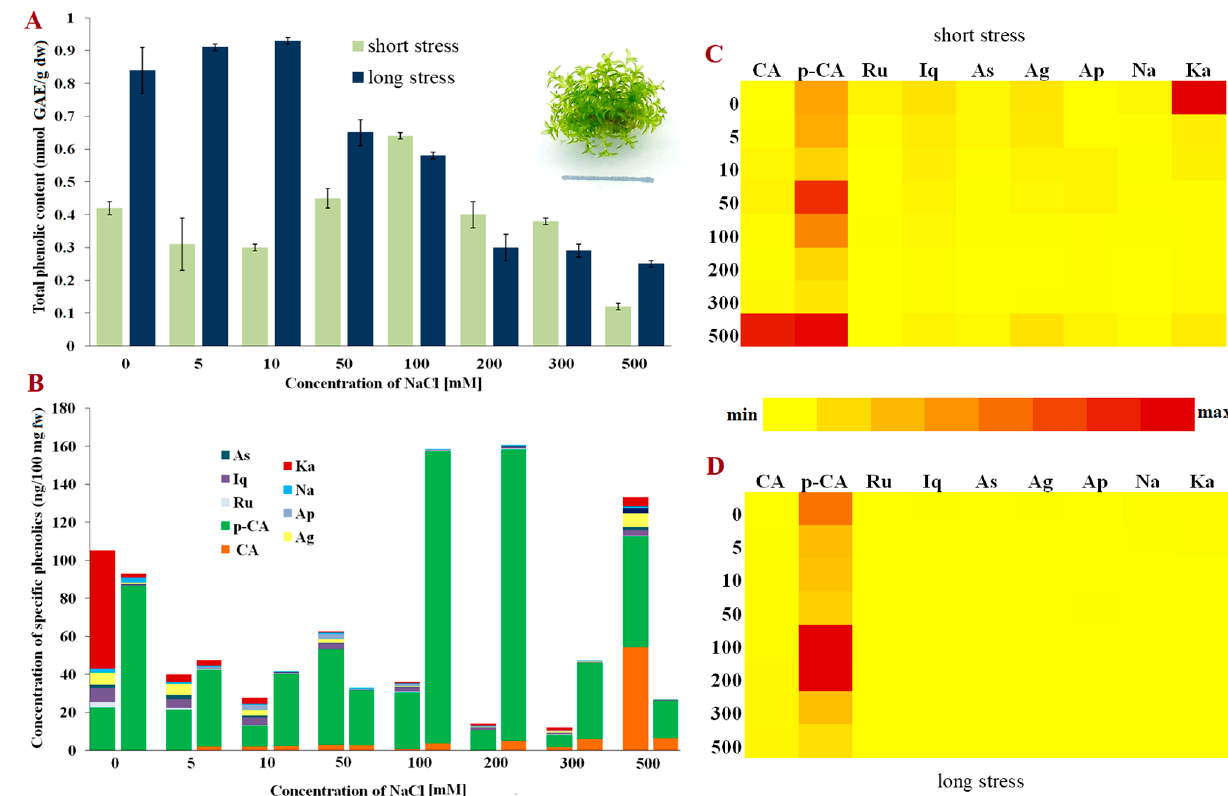
Figure 1. Phenolic content in Physcomitrium patens . ( A ) Total phenolic content in short- and long-term stress; ( B ) Content of phenolic compounds; ( C ) Relative representation of phenolic compounds in short-term stress; ( D ) Relative representation of phenolic compounds in long-term stress. Abbreviations: astragalin (As), isoquercitrin (Iq), rutin (Ru), p-coumaric acid (p-CA), caffeic acid (CA), kaempferol (Ka), naringenin (Na), apigetrin (Ap), apigenin (Ag), gallic acid (GAE), fresh weight (fw) and dry weight (dw).